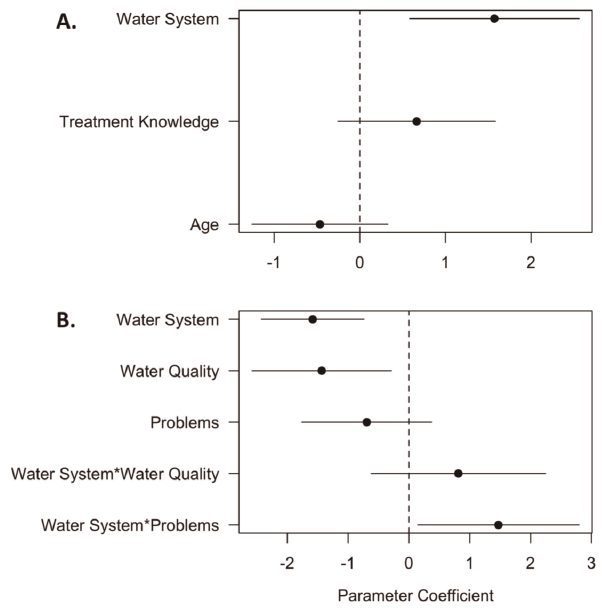
Figure 2. Parameter Estimate Plot of All Variables Considered in the Two Models that Predict Household Water Management Strategies. Standard errors are plotted as black lines. The variable is significant if standard error bars do not cross the zero axis. For the number of water sources (A), institution type is significant (p , 0.005). For whether households treat water (B), institution type (p , 0.001), perceptions of water quality (p , 0.05), and the interaction between institution type and if households have a problem with institutional management (p , 0.05) are significant.